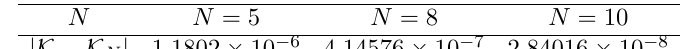
Table 6. Absolute errors of K for different values of N in Example